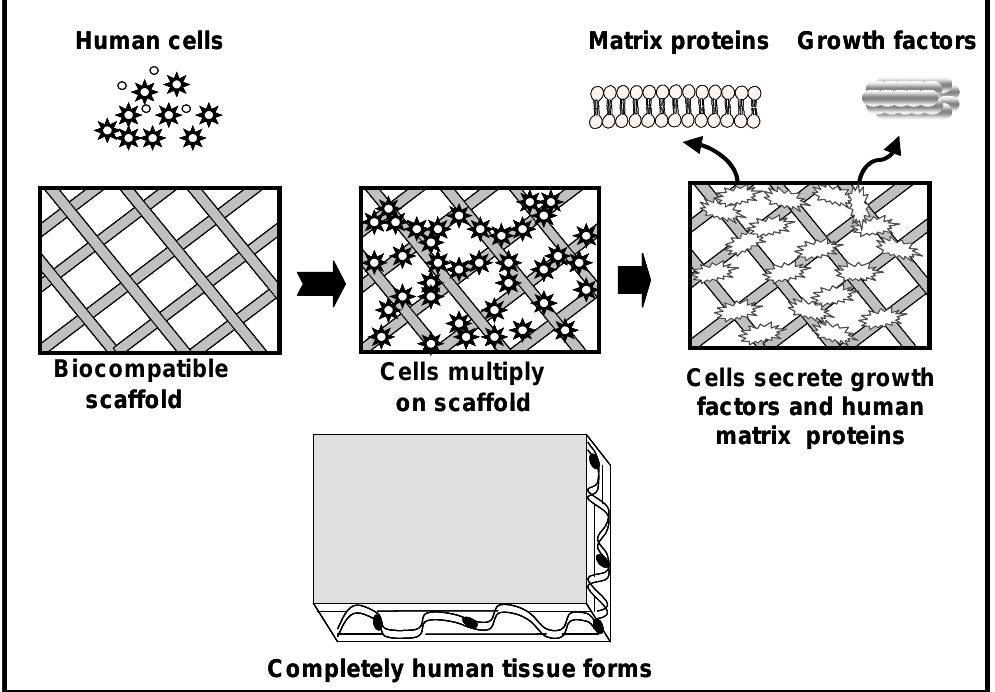
Figure 3. Cell-based tissue regeneration approach for the repair of bone